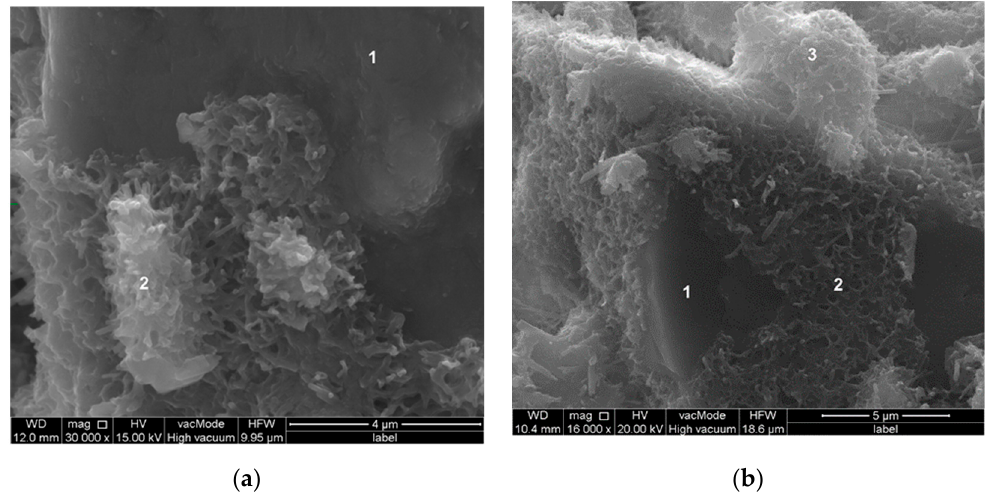
Figure 10. Microstructure of paste with basalt dust: ( a ) after 2 h of hydration; ( b ) after 5 h of hydration; point 1—basalt dust grain, points 2 and 3—C–S–H phase.